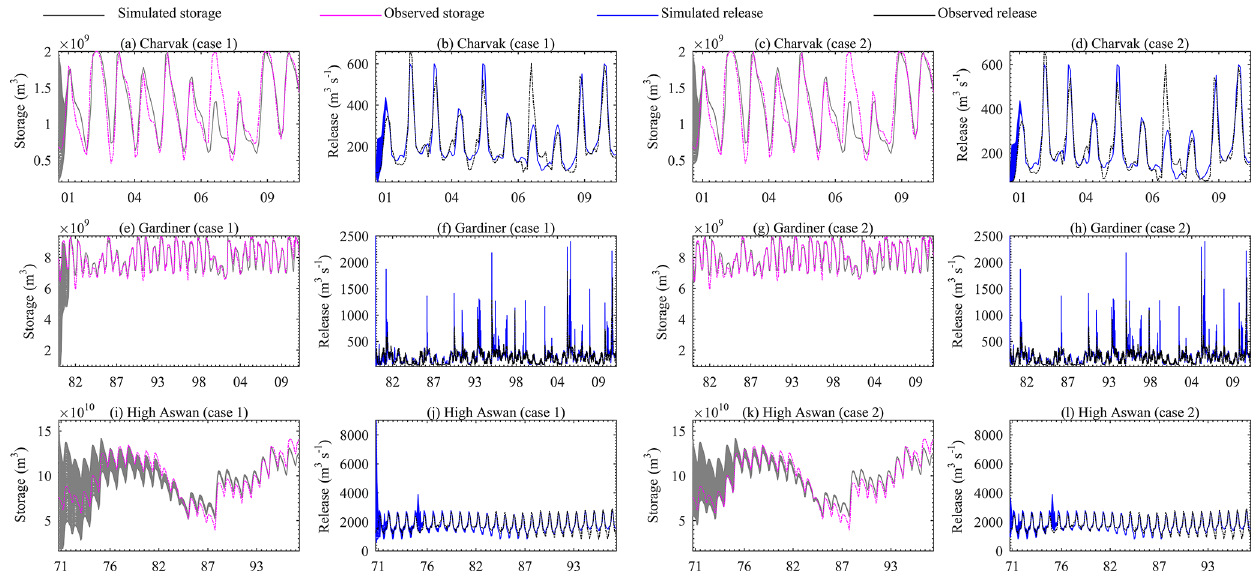
Figure 9. Reservoir initial storage effect on storage and release simulation: (a) Charvak storage case 1, (b) Charvak release case 1, (c) Charvak storage case 2, (d) Charvak release case 2, (e) Gardiner storage case 1, (f) Gardiner release case 1, (g) Gardiner storage case 2, (h) Gardiner release case 2, (i) High Aswan storage case 1, (j) High Aswan release case 1, (k) High Aswan storage case 2, and (l) High Aswan release case 2. Table 2. Reservoir initial storage effect on storage and release